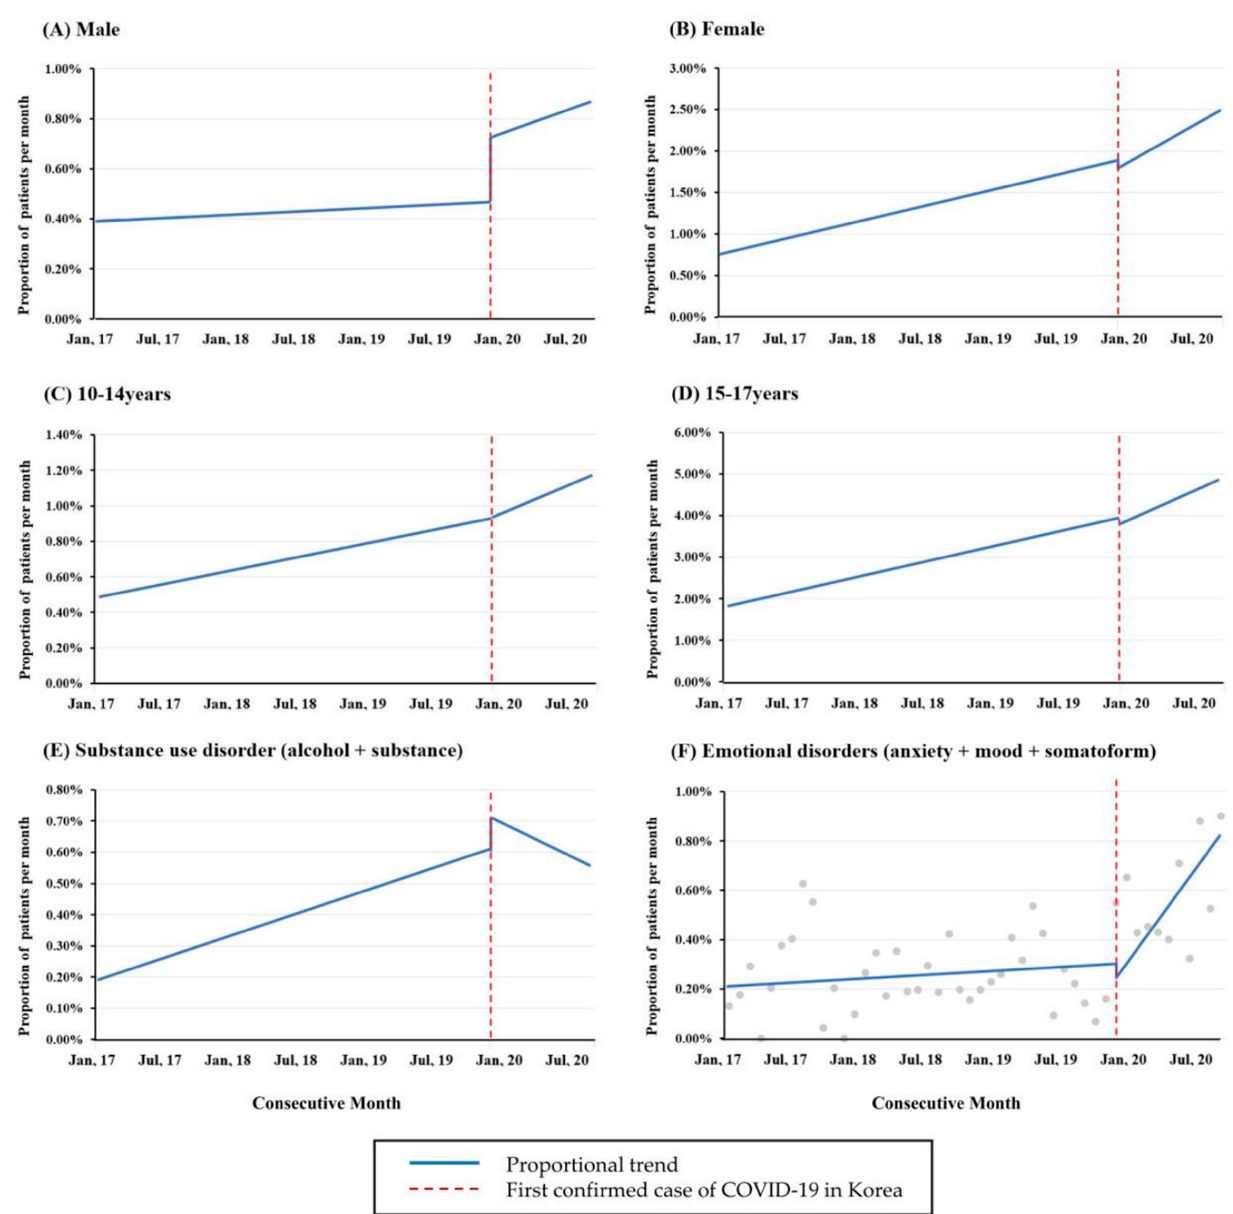
Figure 3. The segmented regression analysis of the monthly proportion of subgroups of patients with mental illness. ( A ) Male, ( B ) Female, ( C ) 10–14 years, ( D ) 15–17 years, ( E ) substance use disorder, and ( F ) emotional disorders. The changes in the proportion of male, female, 10–14 years group, 15–17 years group, and substance use disorders before and after the COVID-19 pandemic were not statistically significant. The proportion of patients with emotional disorders increased significantly by 0.06% per month during the COVID-19 pandemic ( p < 0.001). COVID-19, coronavirus disease 2019.